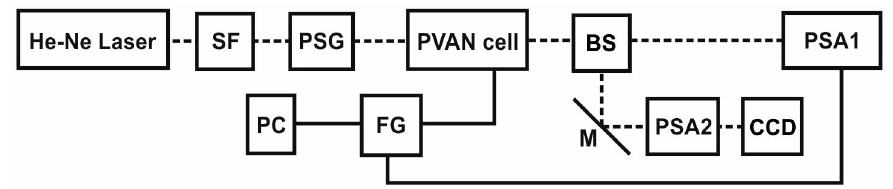
Figure 2. Integrated polarimetric and crossed polarizers’ set-ups for depolarization properties characterization of a PVAN cell. SF—spatial filter module, PSG—SOP generator, BS—beam splitter, PSA1—polarimeter as a SOP analyzer, M—mirror, PSA2—SOP analyzer as a linear polarizer with vertical orientation, FG—function generator, PC—personal computer.